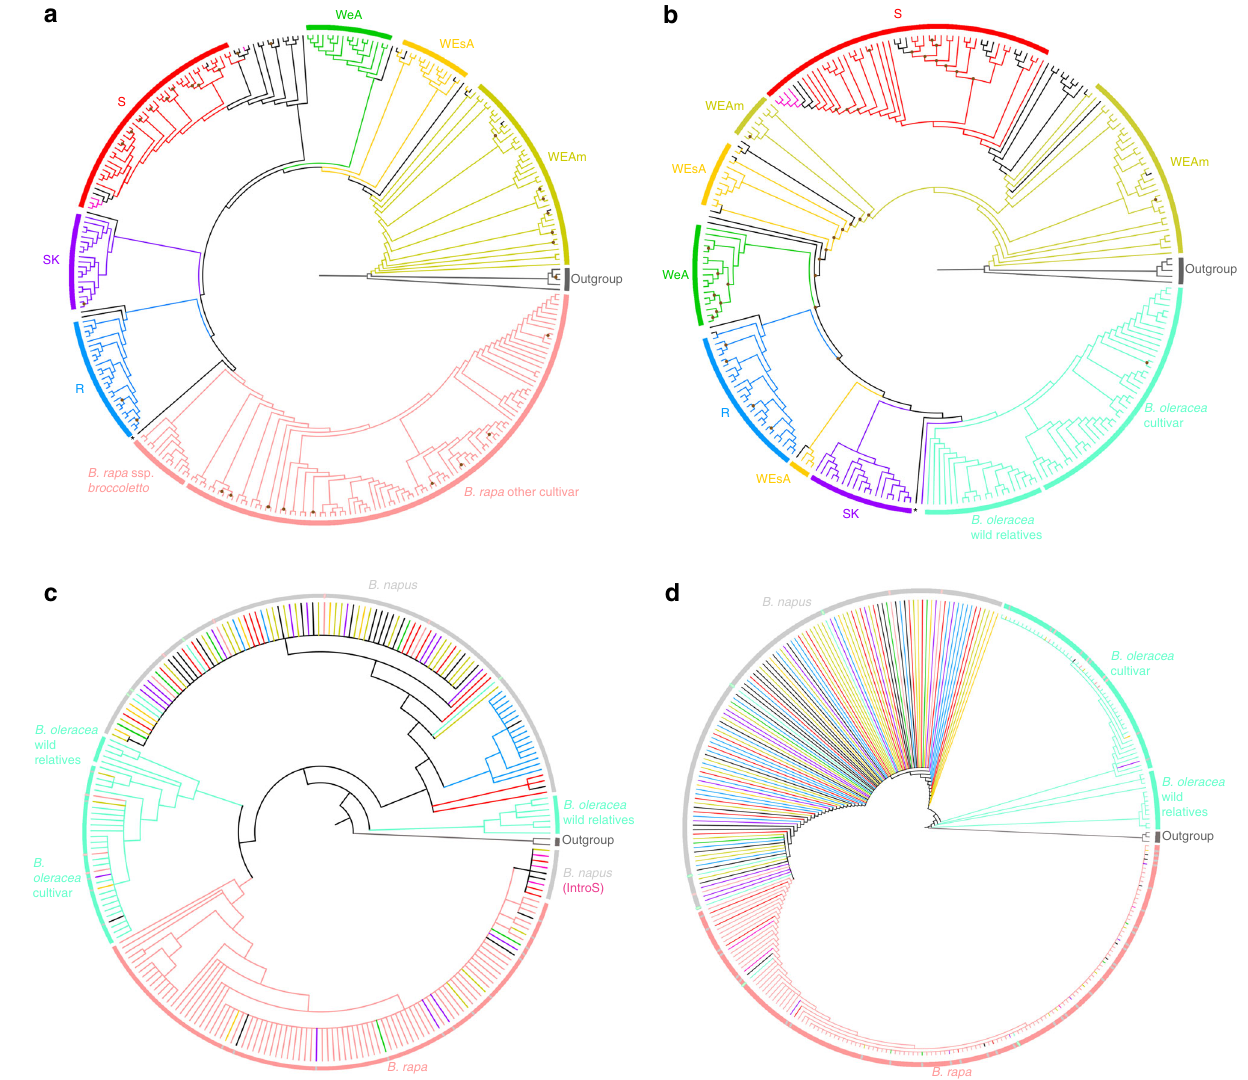
Fig. 2 Phylogenetic analyses of B. napus and its progenitors. Maximum-likelihood phylogenetic tree constructed among: a B. napus and B. rapa based on the A sub-genome (24,193 SNPs); b B. napus , B. oleracea , and wild C species based on the C sub-genome (23,387 SNPs); c Chloroplast phylogeny of B. napus and all its progenitor species ( B. rapa , B. oleracea , and wild C species) using 62 chloroplast genes; d Mitochondria phylogeny of B. napus and all its progenitor species using 42 mitochondrial genes. *: resynthesized B. napus accession New Hakuran; WEAm: Winter rapeseed in Europe and America;